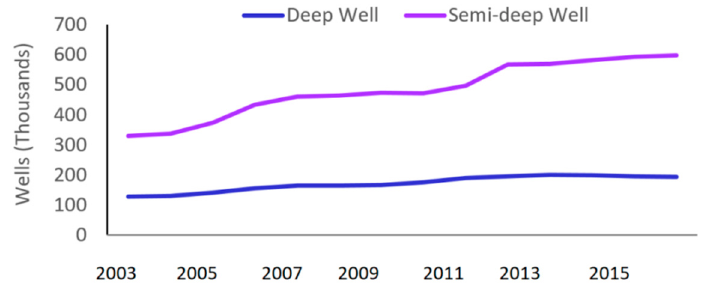
Figure 7. Historical trend of groundwater withdrawal from different sources in Iran.